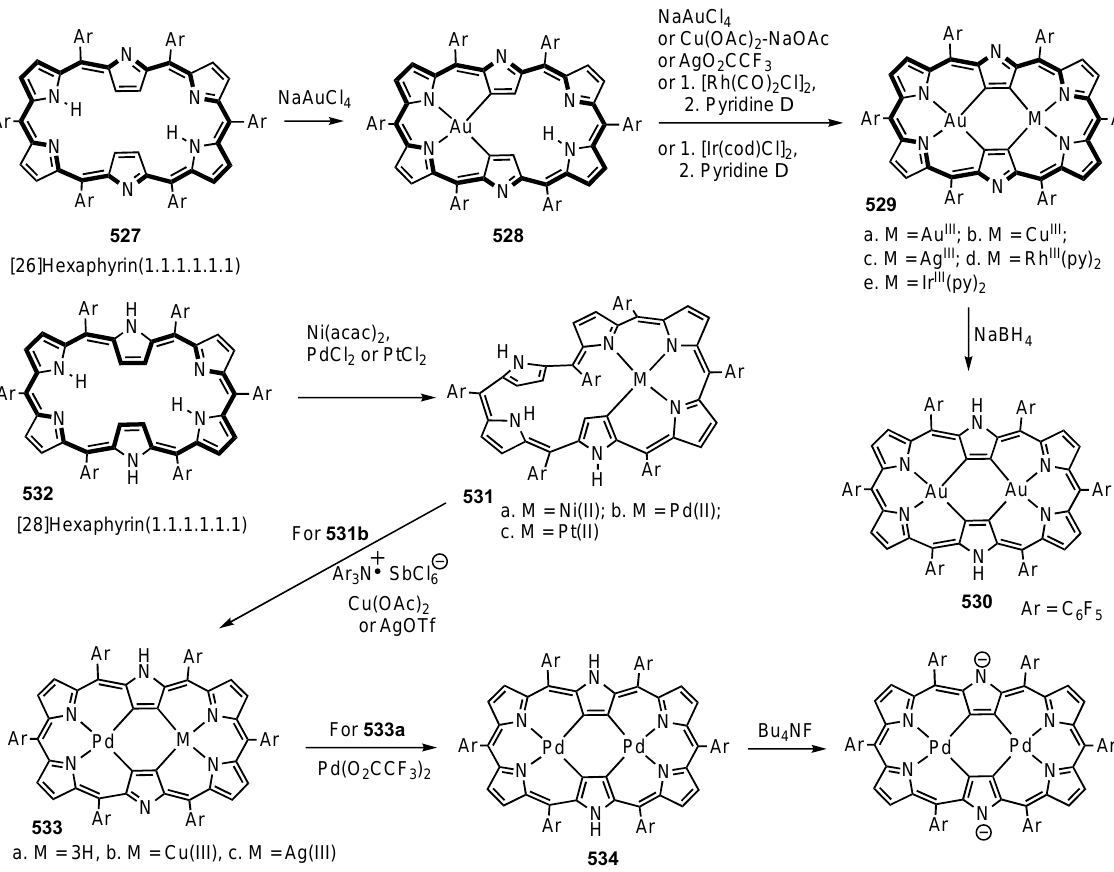
porphyrins with m -phenylene or p -phenylene units have been described and these may also give organometallic derivatives. For example, dibenzihexaphyrin 540 reacted with palladium(II) chloride and potassium carbonate to give Möbius aromatic palladium(II) yield, while reaction with silver triflate in acetonitrile afforded Pd(II)-Ag(III) complex complex 541 (Scheme 83) [340]. Other examples include the Möbius aromatic palla- 533c in 93% yield [336]. Treatment of 533a with Pd(OCOCF 3 ) 2 generated the aromatic bis- dium(II) porphyrinoids 542 and 543 (Figure 14) [341]. These examples illustrate some ex- palladium(II) complex 534 , and this was readily deprotonated with tetrabutylammonium citing examples of organometallic expanded porphyrinoids, but no attempt has been fluoride to produce the corresponding dianion (Scheme 80) [337]. made to give comprehensive coverage of this area.